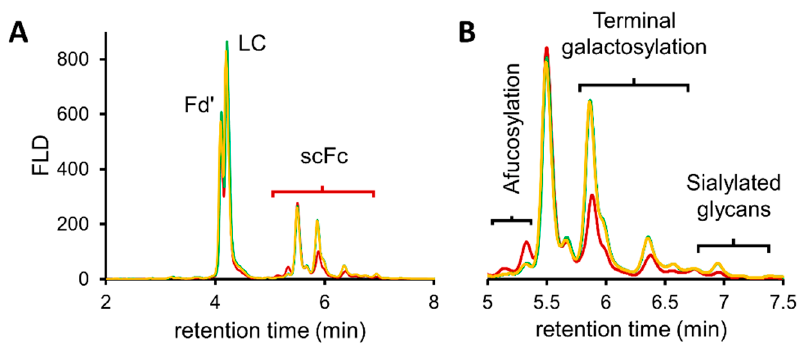
Figure 5. HILIC-MS analysis of infliximab products Remicade ® , Remsima ® and Inflectra ® . ( A ) Fluo- rescence chromatograms of the glycosylated scFc subunit of Remicade ® (red), Remsima ® (green) and Inflectra ® (yellow). ( B ) Zoom on the scFc subunit region with sections assigned for scFc subunits carrying afucosylated glycans, terminal galactosylated glycans and sialylated glycans.